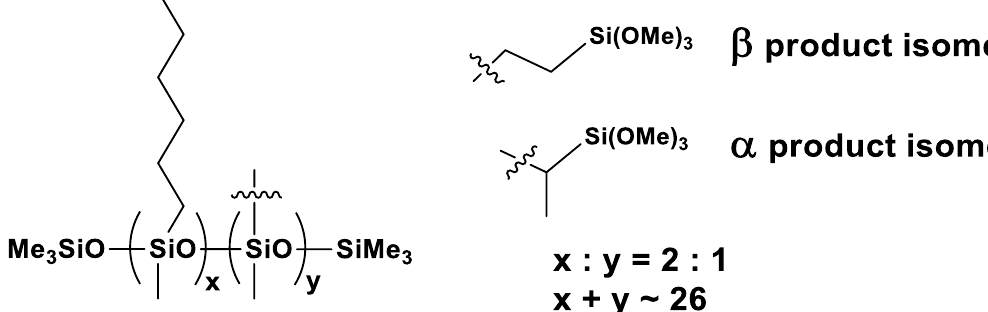
Figure3. Synthesisoftrimethylsilyl-terminatedpoly((hexylmethylsiloxane)-co-(methyl)(trimethoxysilyl)ethyl) Figure 3. Synthesis of trimethylsilyl-terminated poly((hexylmethylsiloxane)-co-(methyl)(trimethoxysilyl)ethyl) siloxane)) (SILOX siloxane)) (SILOX 1).